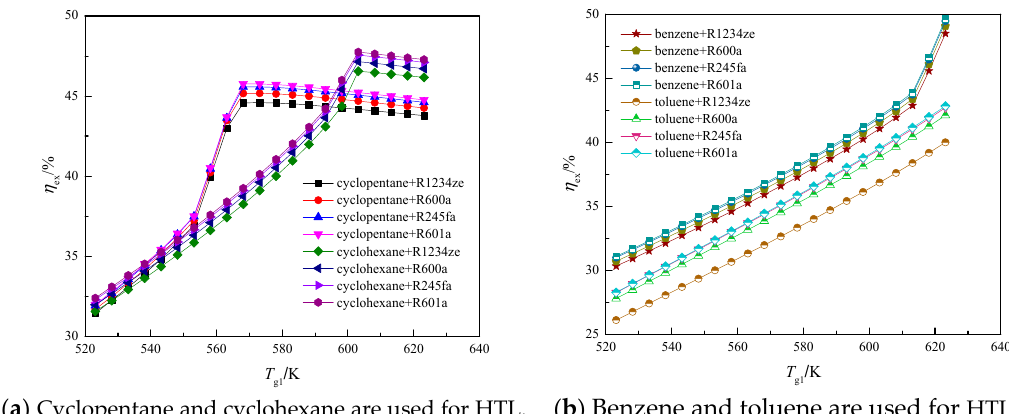
Figure 7. Effects of T g1 on the exergy efficiency.